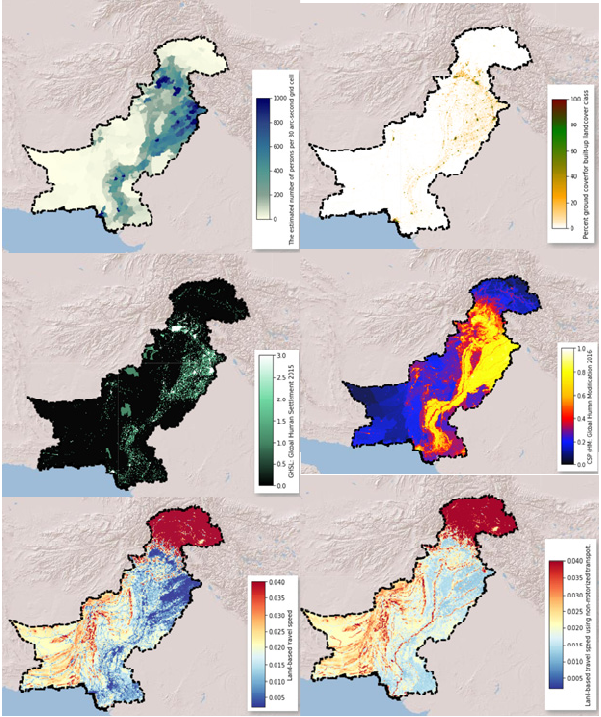
Figure 8. Socioeconomic factors.